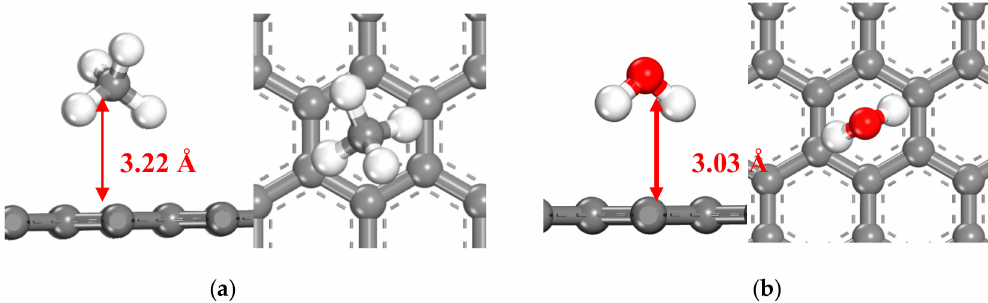
Figure 2. Most stable adsorption geometries of ( a ) CH 4 and ( b ) H 2 O on